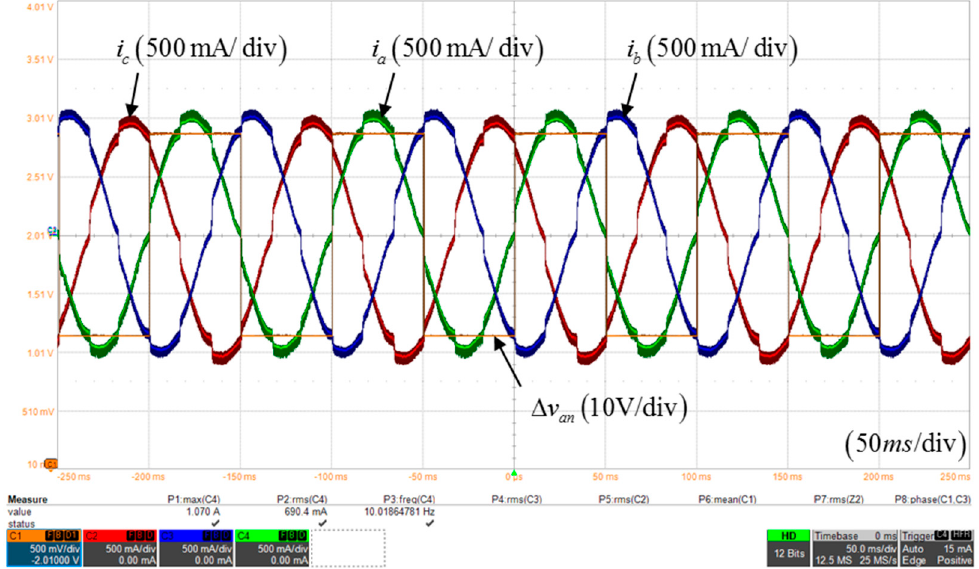
Figure 26. Three-phase currents waveforms and a-phase dead-time compensation pole voltage waveform when DTCS, considering only the proper voltage level, was applied.